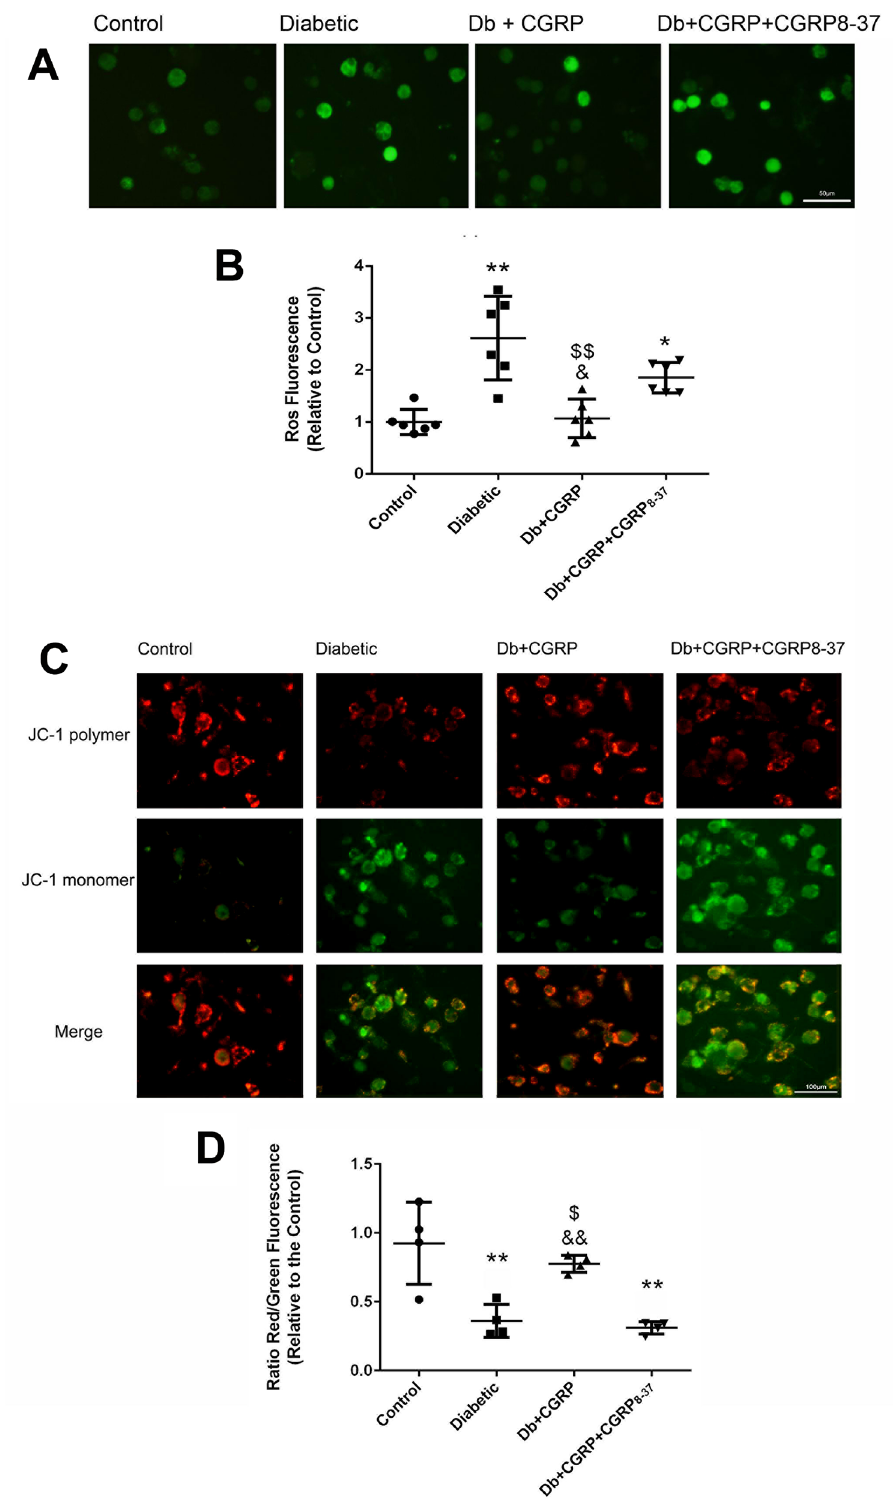
Figure 8. CGRP attenuated over-expression of ROS and the reduction of MMP. ( A ) The representative images of the expressions of ROS in the DRG neurons in groups of control, Diabetic, Db + CGRP and DB + CGRP + CGRP 8–37 , indicate an effective and specific receptor mediated anti-oxidative action of CGRP ( A , B ). The representative images in figure ( C ) show the changes in mitochondrial transmembrane potentials (MMP) in the DRG neurons, indicating the declined MMP in the neurons from the diabetic animals (Diabetic) and an effective and specific receptor mediated action of CGRP in reversion of the impairment of the MMP in the diabetes insulted neurons ( C , D ). Control neurons from the age matched non-diabetic animals, Db + CGRP the neurons collected from the diabetic animals, treated with CGRP, Db + CGRP + CGRP 8–37 the neurons collected from the diabetic animals, treated by CGRP 8–37 then by CGRP. * p < 0.05, compared to the control; ** p < 0.01, compared to the control; $ p < 0.05, compared to diabetic group; $$ p < 0.01, compared to Diabetic group; & p < 0.05, compared to Db + CGRP + CGRP 8–37 group; && p < 0.01, compared to Db + CGRP + CGRP 8–37 group. The scales = 50 µm in ( A ) and 100 µm in ( C ),